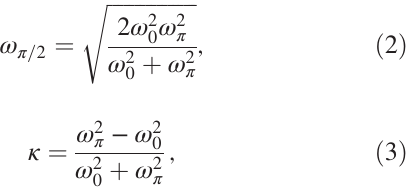
=E 2 as a function of c acc